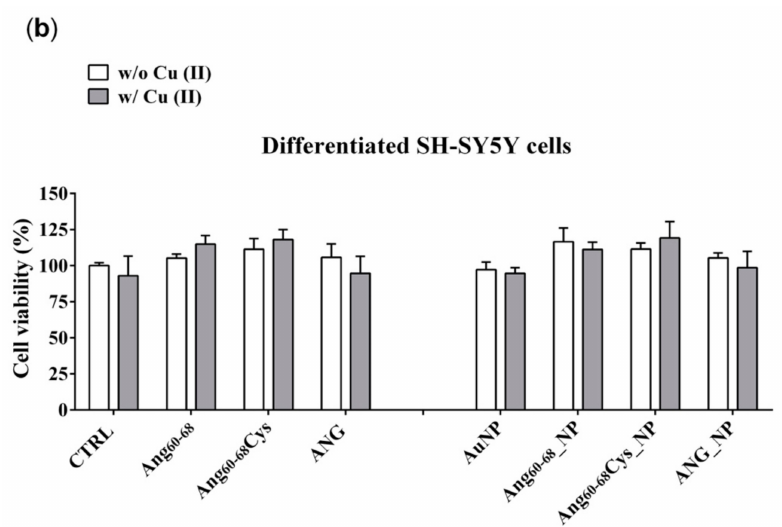
Figure 3. Cell viability determined by 3-(4, 5-dimethylthiazolyl-2)-2, 5-diphenyltetrazolium bromide (MTT) assay of A172 ( a ) and d-SH-SY5Y ( b ) cell lines. Cells were grown in basal culture medium (control: CTRL) and in culture medium supplemented with: Ang 60–68 (30 µ M), Ang 60–68 Cys (30 µ M); ANG (100 nM), AuNP (9.4 nM = 1.4 × 10 8 NP / mL), Ang 60–68 _NP (1.4 nM = 4.0 × 10 6 NP / mL, [Ang 60–68 ] = 2.8 × 10 − 12 M), Ang = 4.0 × 10 6 NP / mL, [Ang = 2.6 × 10 − 12 M), 60–68 Cys_NP (1.4 nM 60–68 Cys] ANG_NP (1.2 nM = 3.4 × 10 6 NP / mL, [ANG] = 0.2 × 10 − 12 M). All conditions were evaluated in presence or absence of metal ions (copper sulphate: Cu(II), 20 µ M). The bars represent means ± SD of three independent experiments performed in triplicate (S.D. = standard deviation). Statistically significant di ff erences, determined by one-way analysis of variance ANOVA are indicated: * p ≤ 0.05 versus CTRL; § p ≤ 0.05 versus the respective treatment with free peptides / protein; (cid:7) p ≤ 0.05 versus the respective treatment w / o